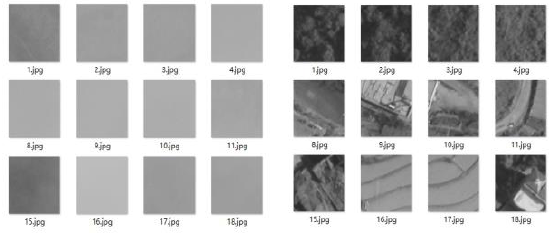
Figure 4. Positive and negative